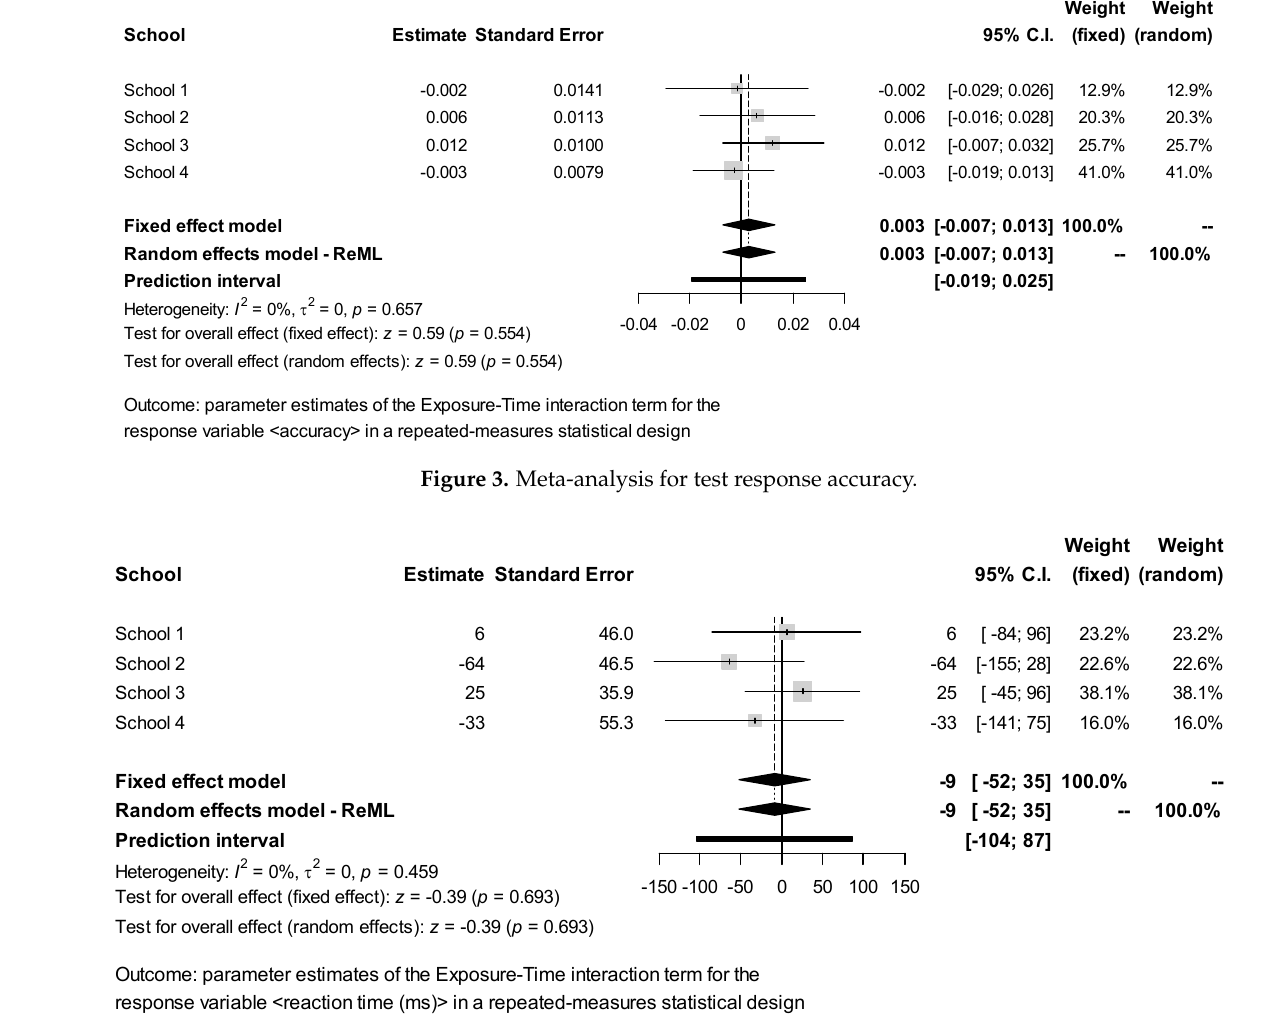
Figure 4. Meta ‐ analysis for test response reaction time.